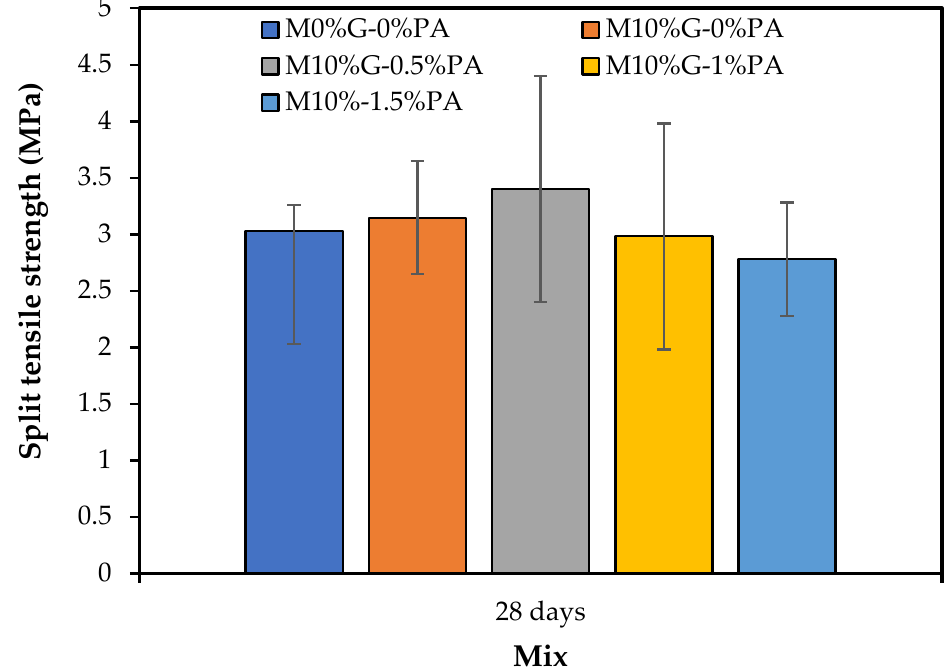
Figure 10. Split tensile strength for cylinders with powder glass and PA fibers (3 cylinders/mix).